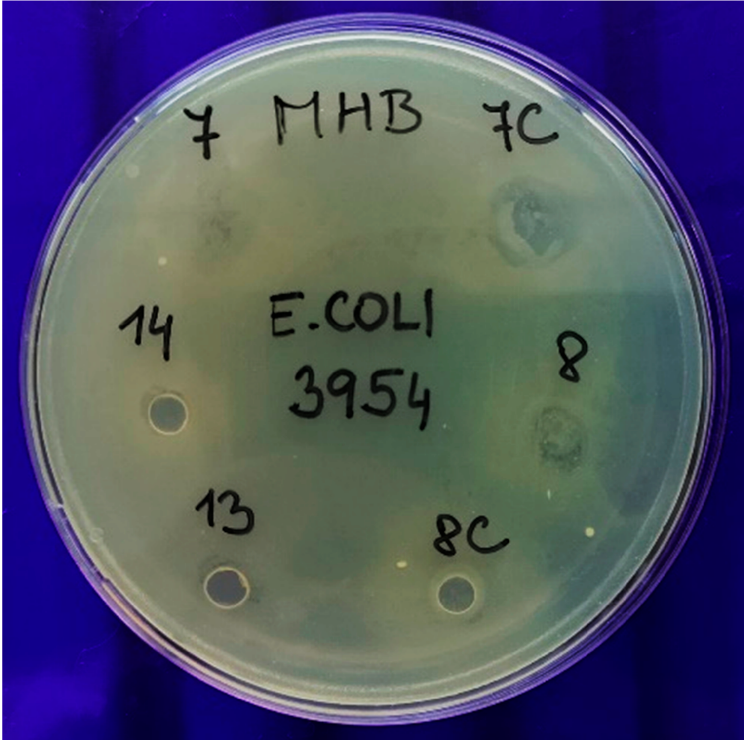
Figure 11. Evaluation of antimicrobial activity based on overgrowth of microbial culture over the disc of edible envelope; evaluation scale 1–5 (1 = disc completely clean; 5 = disc completely overgrown). The results are designated as follows: 7: 0.3gTr1OT80; 7C: 0.3gTr1; 8: 0.3gTr3OT80; 8C: 0.3gTr3; 13: OT20; 14: Tr0.5OT20.